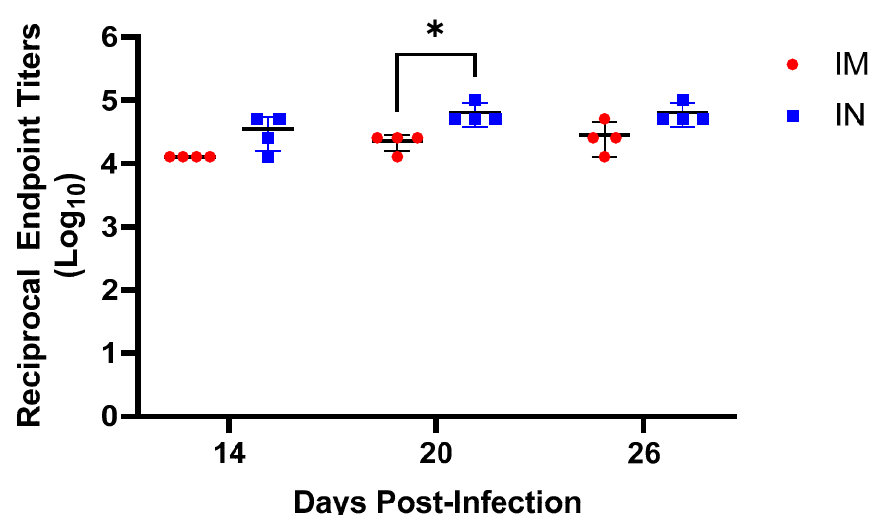
Figure 5. Endpoint titers of TAFV GP-specific IgG. Plasma samples were collected from each animal at 14, 20, and 26 dpi and subjected to ELISA to quantify total amounts of circulating TAFV GP-specific IgG. Values reported represent lowest reciprocal dilution (Log 10 ) above the cut-off. IM, intramuscular inoculation; IN, intranasal inoculation. * indicates a p -value ≤ 0.05.